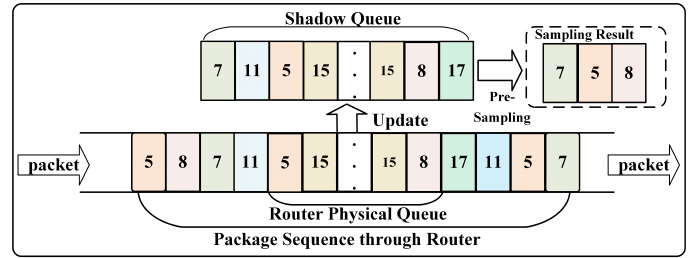
Figure 6. The SQ’s principle.